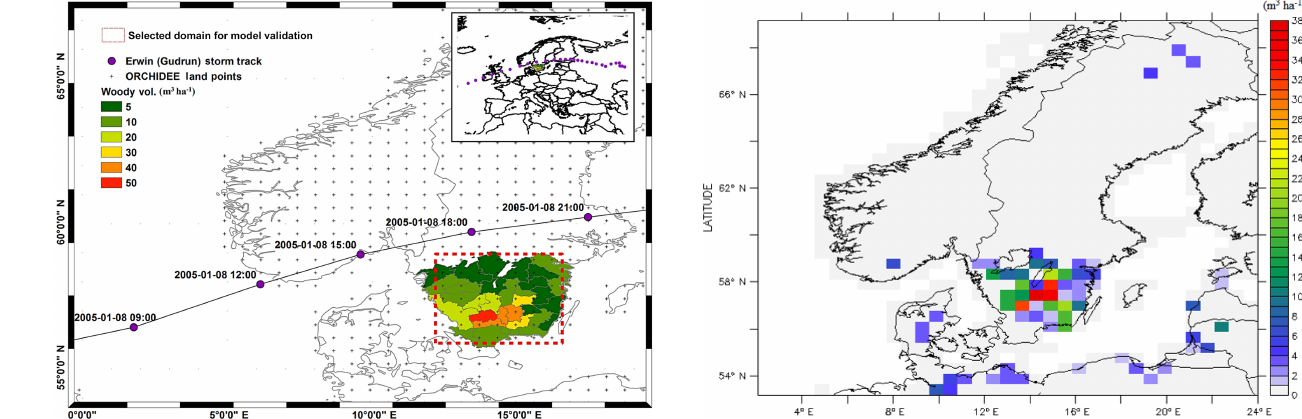
Figure 8. Simulated spatial distribution of the damaged wood vol- ume (m 3 ha − 1 ) over southern Sweden by Gudrun in January